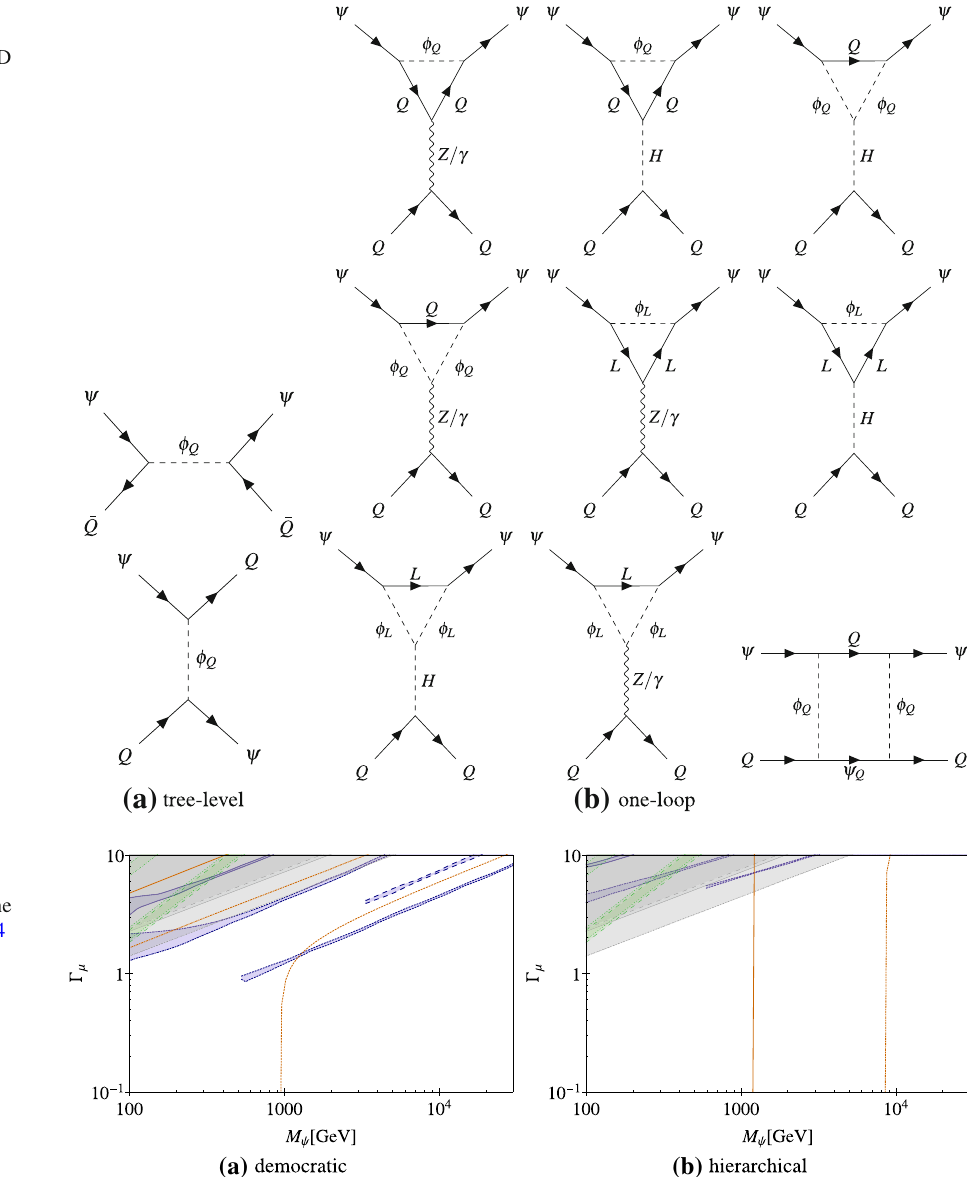
Fig. 15 Tree-level ( a ) and one-loop ( b ) DM-quark diagrams contributing to the DD cross section of ψ Q DM